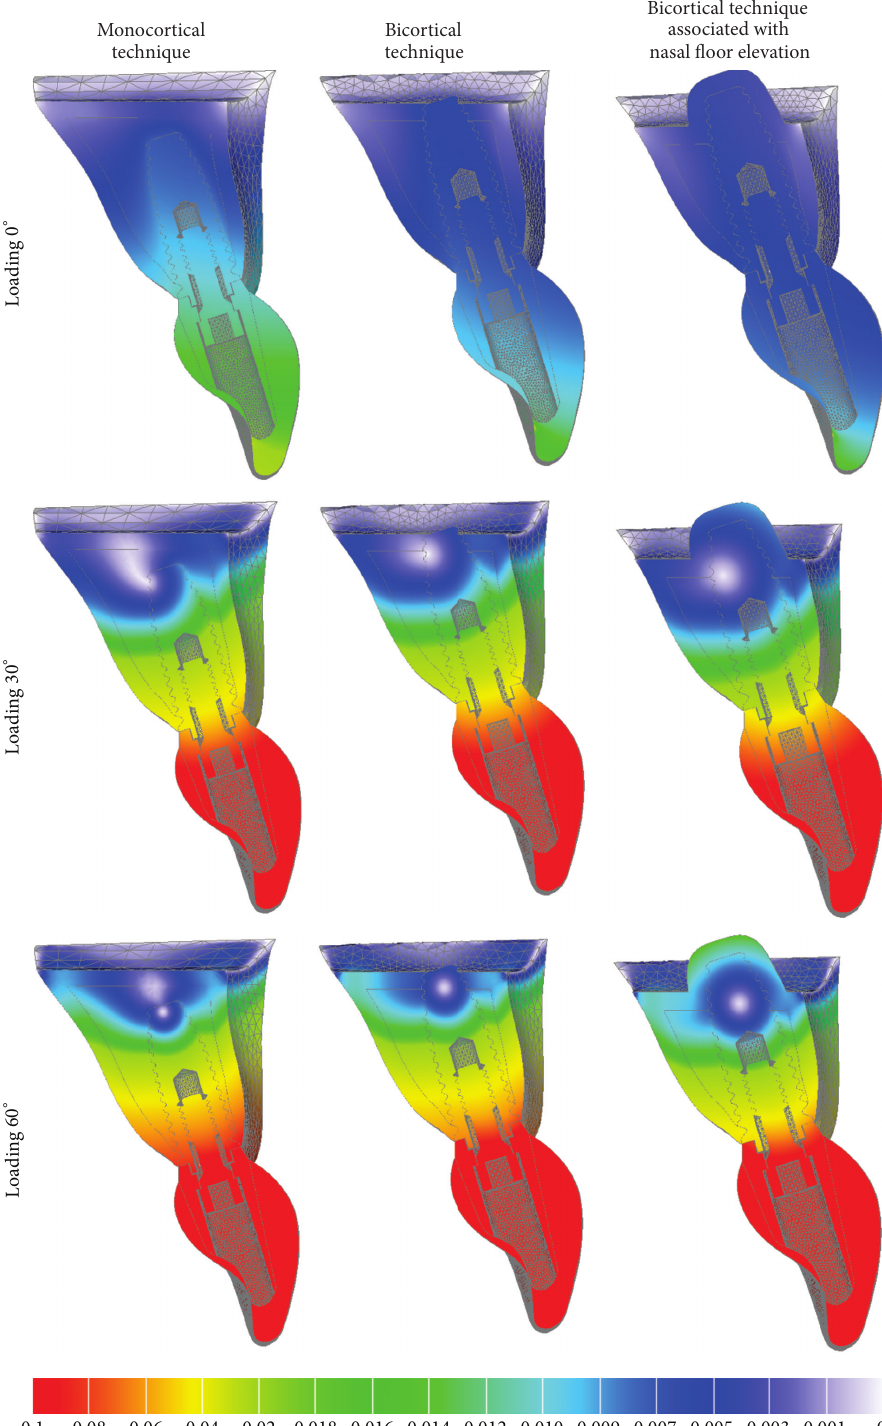
Figure 5: Displacement analysis of all models in sagittal view for different